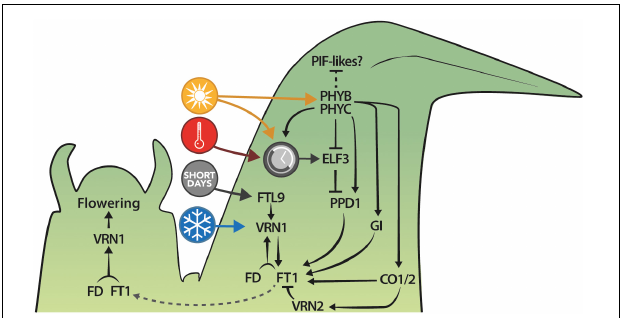
FIGURE 5 | Summary of the current understanding of the photoperiodic regulation of flowering in B. distachyon . Colored circles represent the ambient temperature (red), the photoperiod (yellow), the circadian clock (gray), and the vernalization (blue)